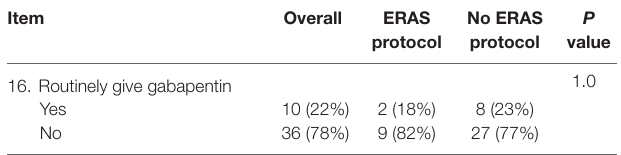
Table 2 | Survey items with similar responses from institutions with and without ERAS